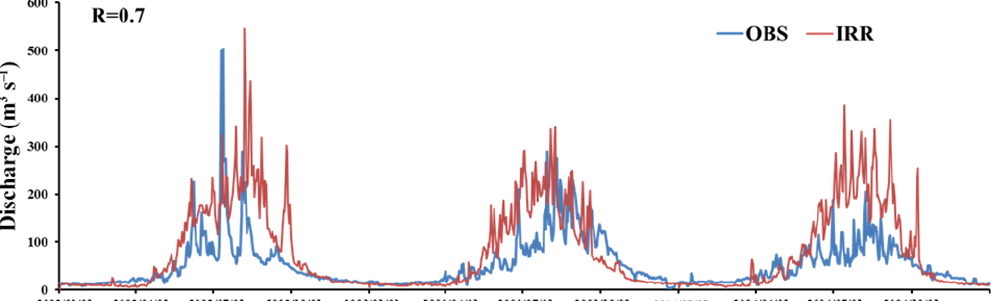
Figure 5. Time series for the modeled and observed daily streamflow over Yingluoxia Gorge from 2002 to 2004.